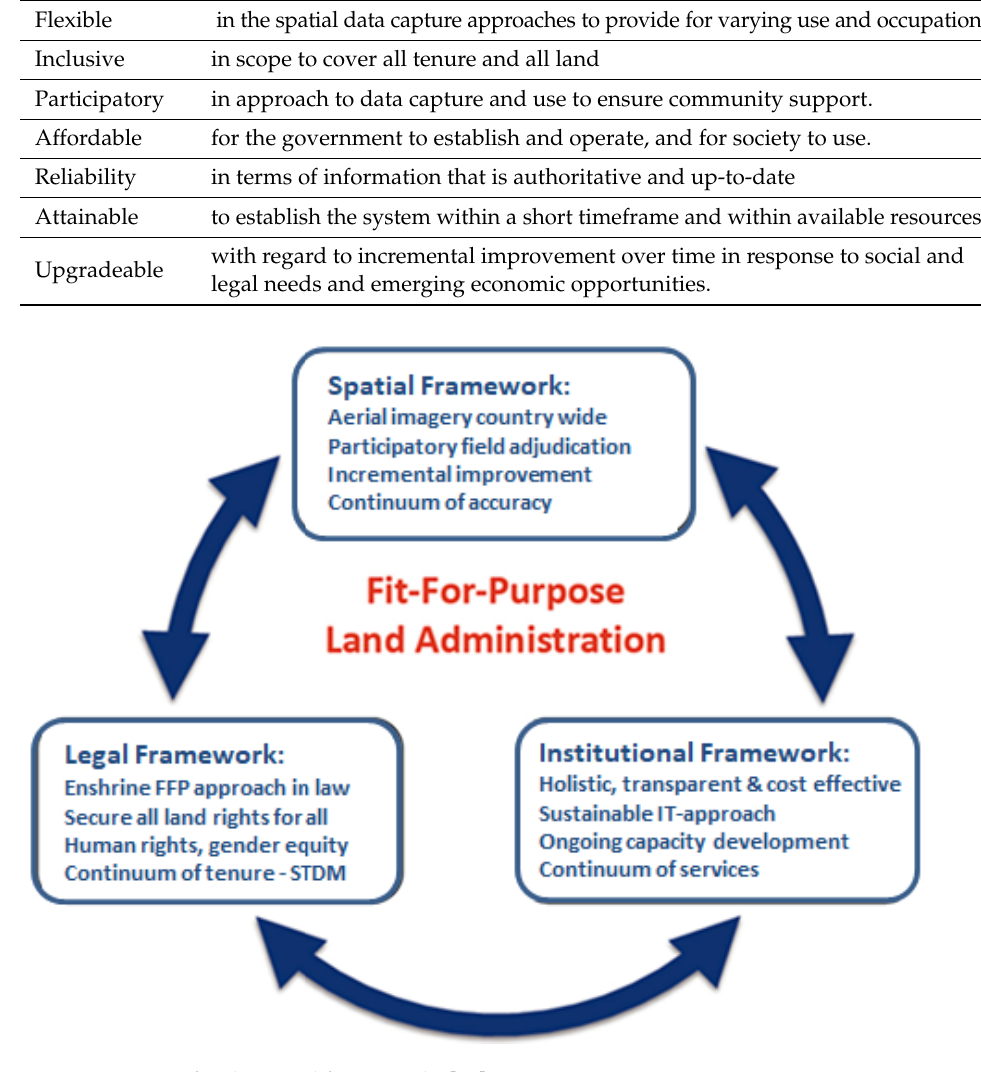
Figure 1. FFPLA fundamental frameworks [14]